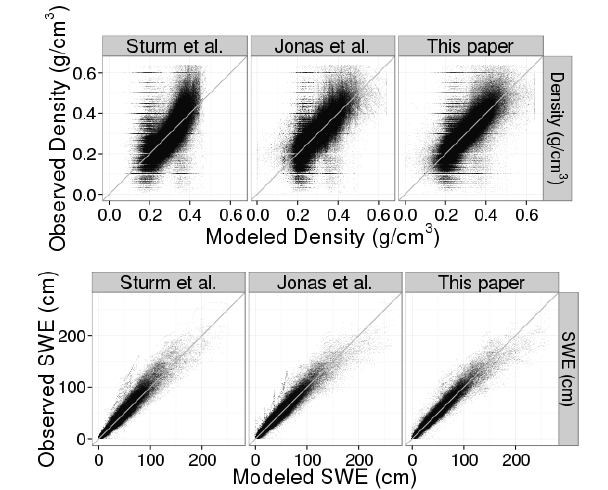
Fig. 6. Scatter plots of observed and modeled bulk density (top) and SWE (bottom) for all 3